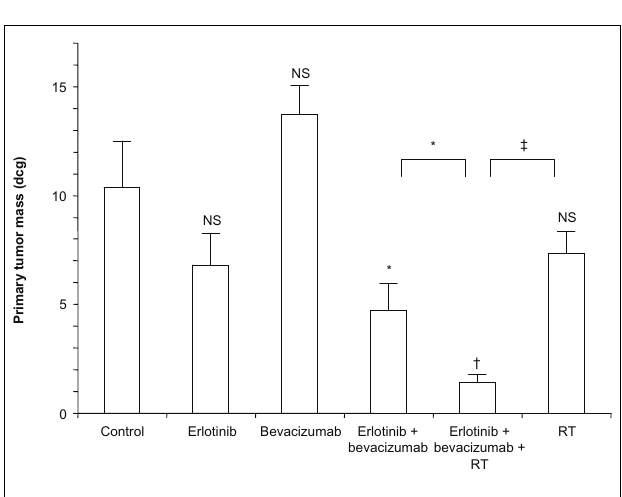
FIGURE 2 | In vivo activity of erlotinib with or without radiotherapy (RT) in tumor xenografts. H226 (10 6 ) or UM-SCC6 (10 6 ) cells were injected subcutaneously into the flanks of athymic mice as described. Mice were treated with erlotinib (0.8mg daily via